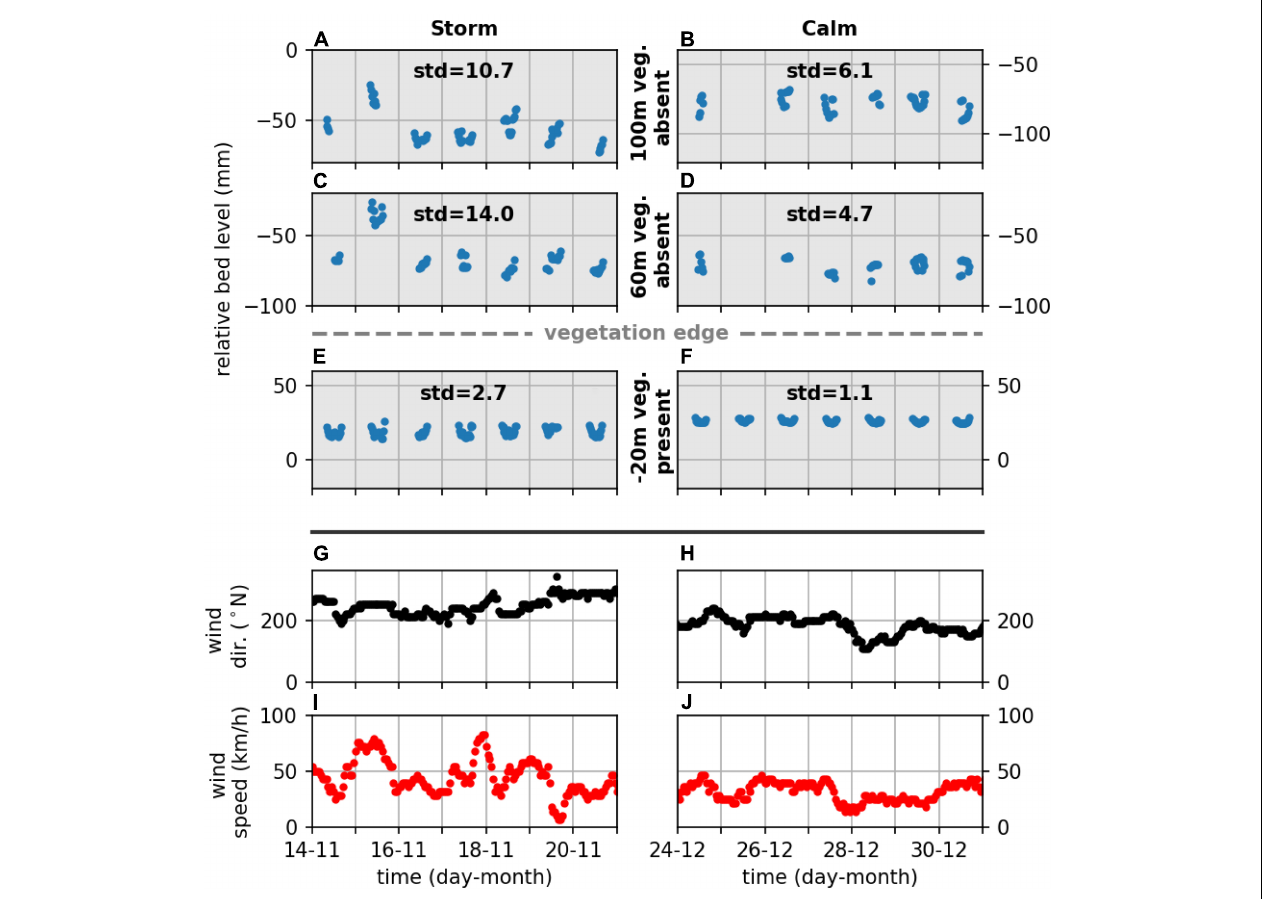
FIGURE 6 | Bed level change [ (A–F) ; blue dots], wind direction [ (G,H) ; black dots] and wind speed [ (I,J) ; red dots], during storm (left) and calm (right) wind conditions for three measurement stations at Zuidgors, two at unvegetated stations (A–D) and one at a vegetated station (E,F) . The standard deviation (mm) of the bed level for the represented time series is printed in the panel (A–F)